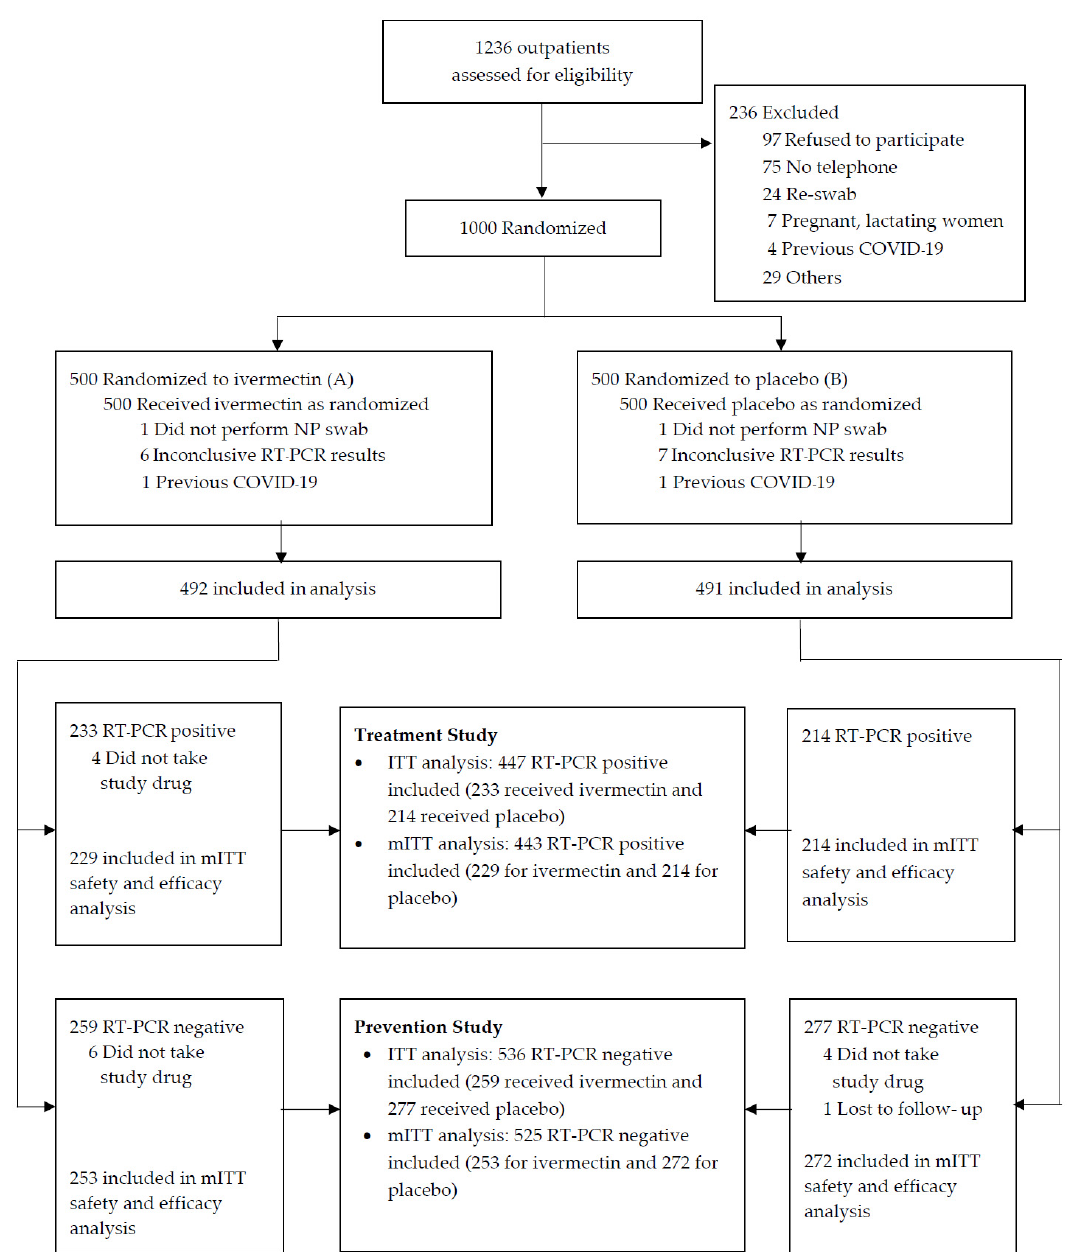
Figure 1. Enrollment, randomization, and treatment assignment .